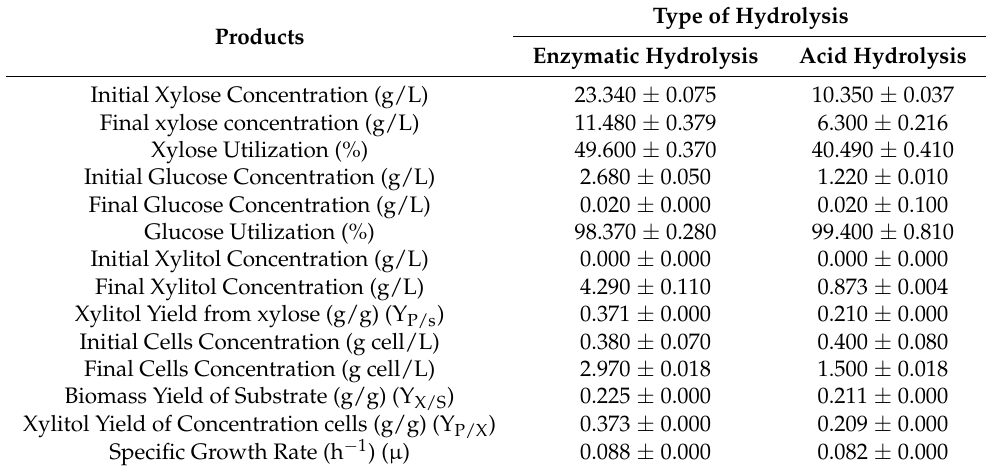
Table 4. Fermentation products of enzyme hydrolysate and acid hydrolysate by C. tropicalis